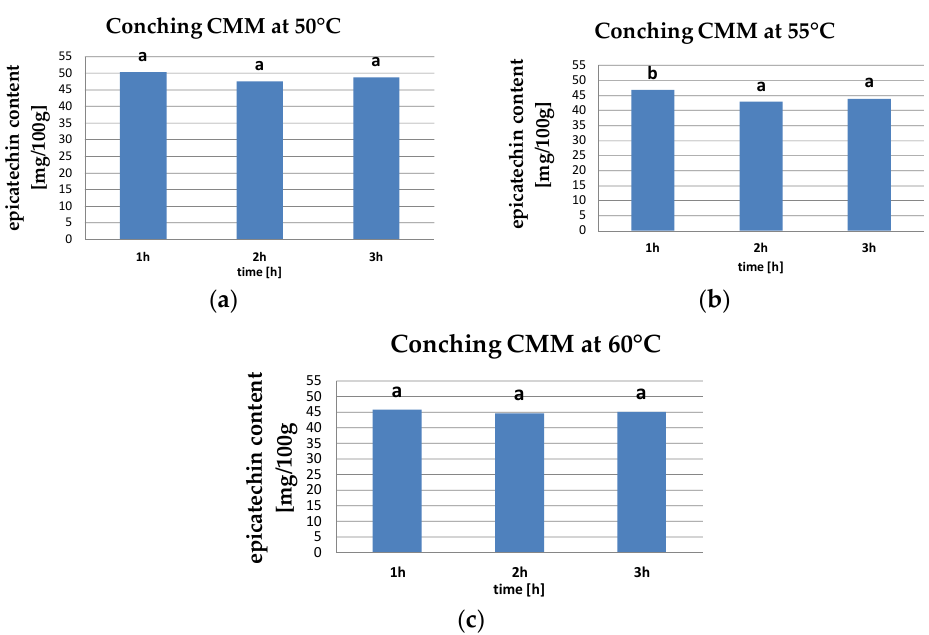
Figure 3. Epicatechin content in CMM at conching temperature of ( a ) 50 °C, ( b ) 55 °C, and ( c ) 60 °C (the same letters mean that there are no statistically significant differences between the values of this indicator at a confidence level of α = 0.05).